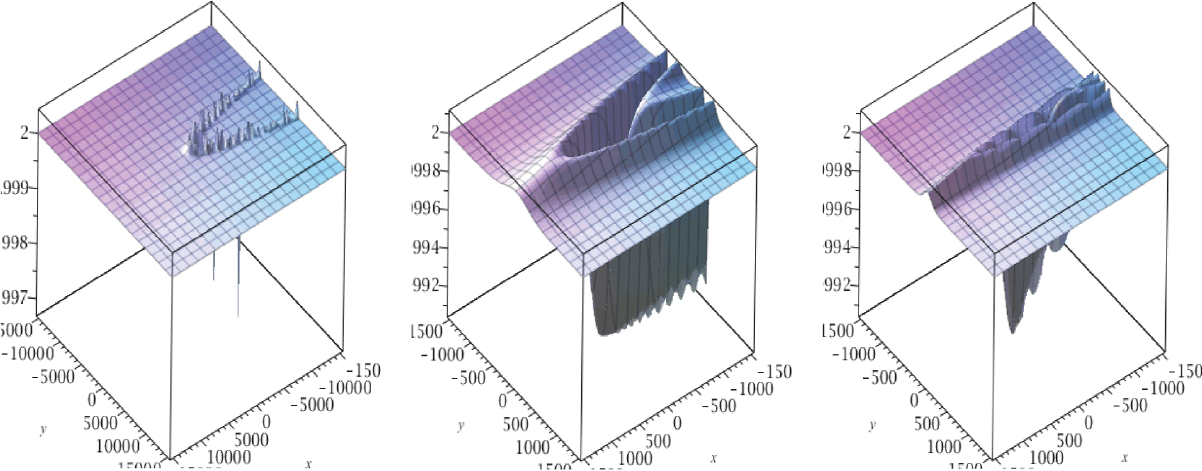
Figure 3: Solution of order 3 to (1), on the left for 𝑡 = 0,01 , 𝑎 1 = 0 , 𝑏 1 = 0 , 𝑎 2 = 10 6 , and 𝑏 2 = 0 ; in the center for 𝑡 = 0, 1 , 𝑎 1 = 10 3 , 𝑏 1 = 0 , 𝑎 = 0 , and 𝑏 = 0 ; and on the right for 𝑡 = 1 , 𝑎 2 2